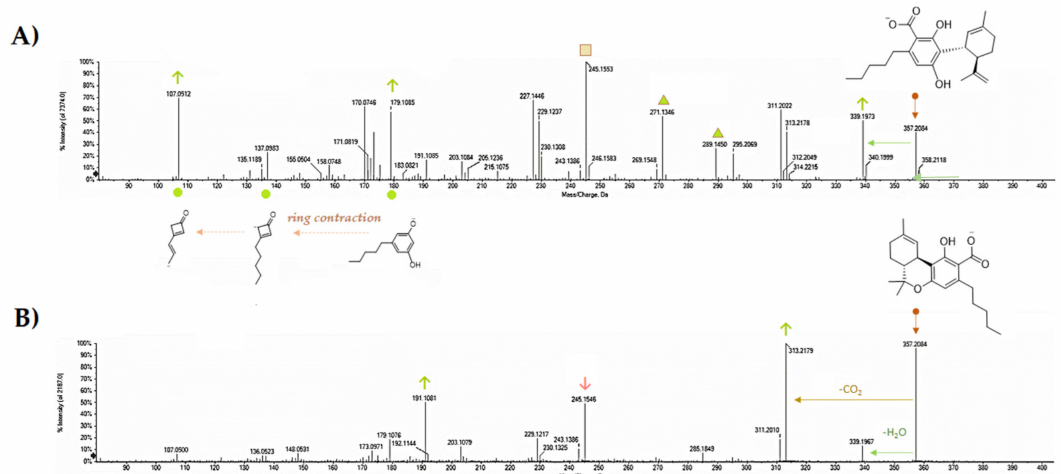
Figure 9. TOF-MS / MS spectra of CBDA ( A ) and ∆ 9 -THCA ( B ) acquired using a hybrid Q-TOF MS instrument, the AB SCIEX Triple TOF ® 4600 (AB Sciex, Concord, ON, Canada) and MS parameters were as follows: curtain gas (CUR) 35 psi, nebulizer gas (GS 1) 60 psi, heated gas (GS 2) 60 psi, ion spray voltage (ISVF) 4.5 kV, interface heater temperature (TEM) 600 ◦ C, declustering potential (DP) − 75 V, and collision energy (CE) − 5. In TOF-MS / MS experiments, collision energy (CE) applied was − 55 V with a collision energy spread (CES) of